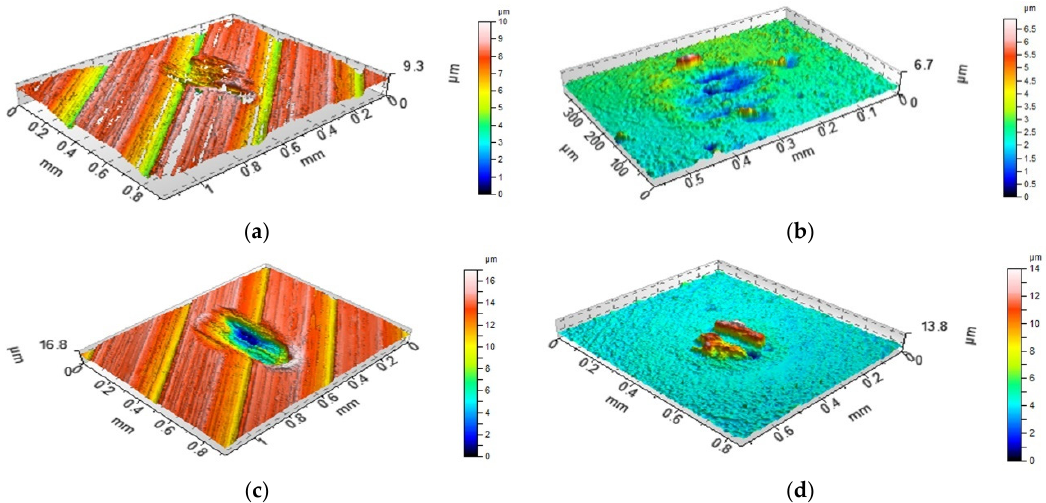
Figure 8. Isometric views of disc M1 ( a , c ) and co-acted balls ( b , d ) after tests A ( a , b ) and B ( c , d ).